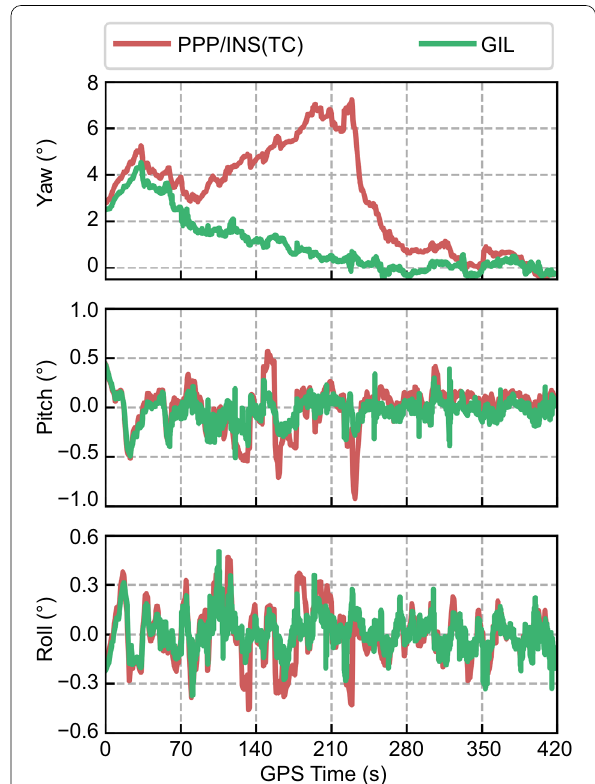
Fig. 16 Attitude offsets of multi-GNSS PPP/INS and GIL methods in GNSS difficult